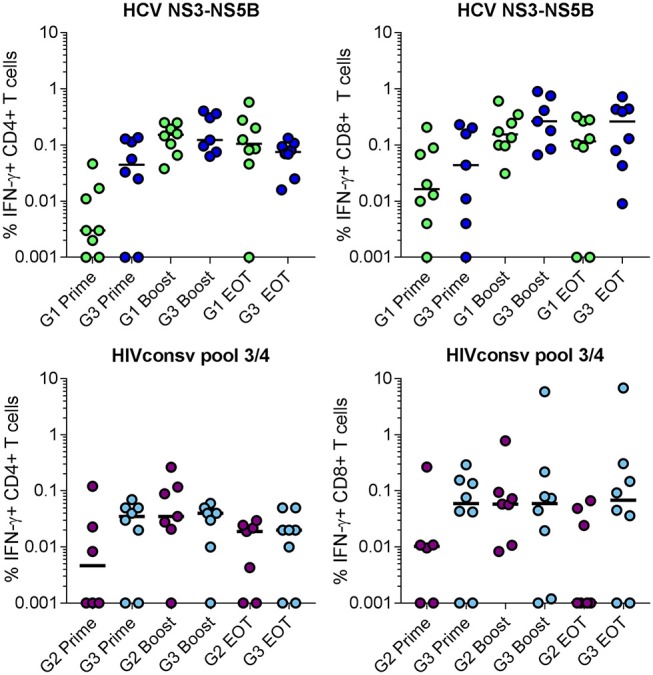
Frequency of total antigen-specific IFN-γ+ cells within (left) CD4+ and (right) CD8+ T populations in volunteers in Groups 1 and 3 (NSmut vaccines, top panels) and Groups 2 and 3 (HIVconsv vaccines, bottom panels) after priming, boosting and at the end of trial (EOT) as determined by intracellular cytokine staining of cryopreserved PBMC. Zero values were arbitrarily assigned a value of 0.001 to enable display on a log10 scale. Horizontal lines indicate median values. Groups were compared using Kruskall-Wallis test; no statistically significant differences were found.